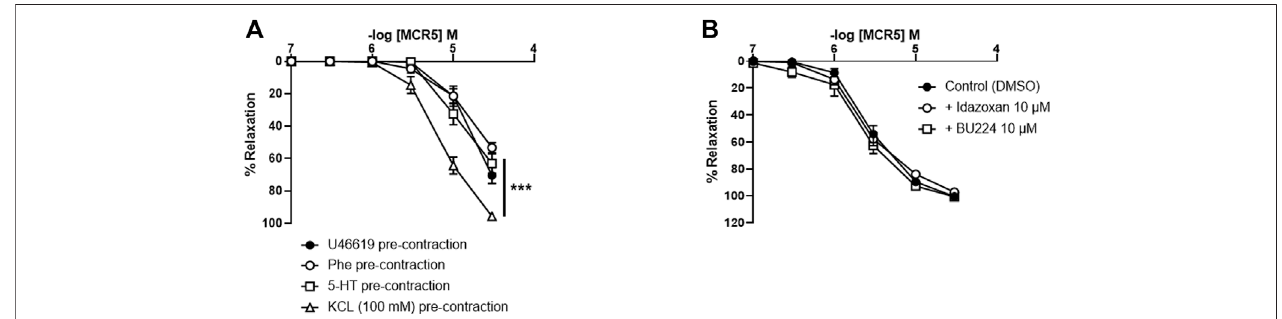
FIGURE3| Effectsofdifferentpre-contractileagonistsonMCR5relaxationsandin fl uenceofI 2 Rmodulation.Concentration-responsecurvestoMCR5inU46619- , phenylephrine (Phe)-, 5-hydroxytryptamine (5-HT)-, and KCL (100 mM)-pre-contracted aortic rings from young OF1 mice (A) . Concentration-response relaxation curvestoMCR5inKCl(100 mM)-pre-contractedaortic ringsintheabsence(Control)orpresenceofidazoxan(10 µM)andBU224(10 µM) (B) .Resultsaremean±SEM from n = 5 (A) and 3-4 (B) mice. ppp p < 0.001 by two-way repeated measures ANOVA with Bonferroni ’ s post hoc